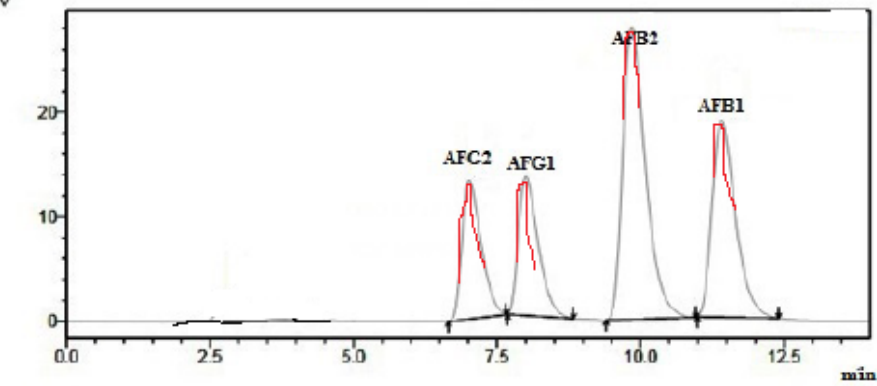
Figure 1. Chromatogram of spiked corn sample with AFB1, AFB2, AFG1 and AFG2.